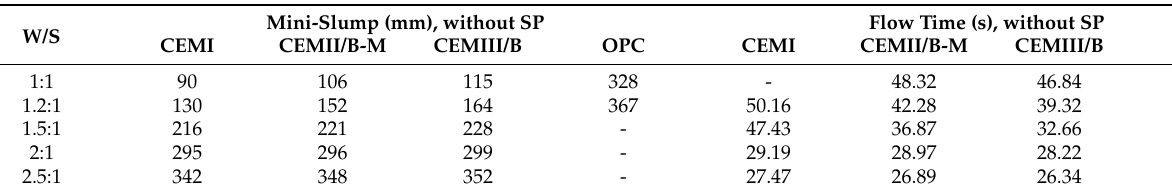
Table 4. Mini-slumps and flow times of fresh SMCG under different W/S in this study.